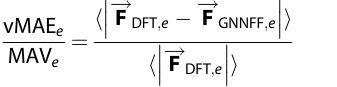
Table 1. For “ test within ” , MAE of GNNFF was 0.036 eV Å − 1 which is